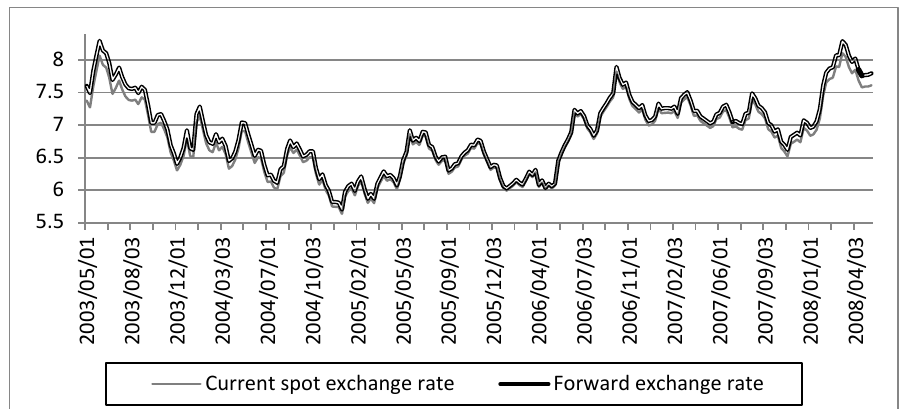
FIGURE 1: The current ZAR/USD spot and 3-month forward exchange rate Source: McGregor BFA